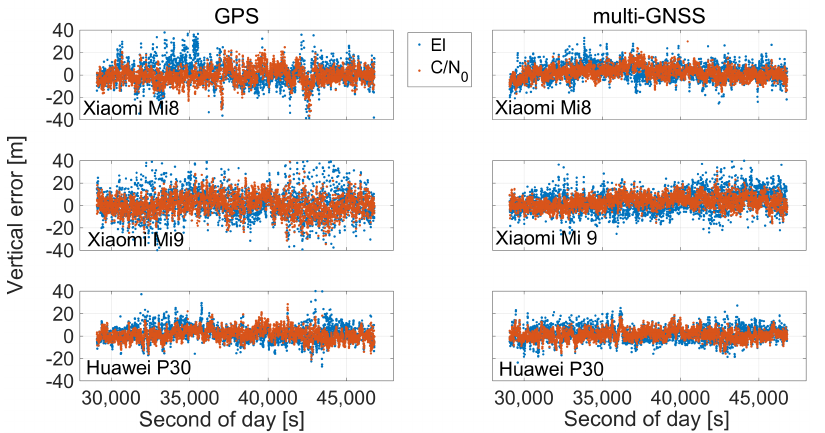
Figure 13. Time series of vertical coordinate component error for single point positioning: elevation (represented in blue marker) versus C / N 0 (represented in red marker) dependent weighting schemes for GPS (first column) and multi-GNSS (second column) solutions. Xiaomi Mi 8, Xiaomi Mi 9 and Huawei P30 smartphones are shown in the top, middle, and bottom rows,